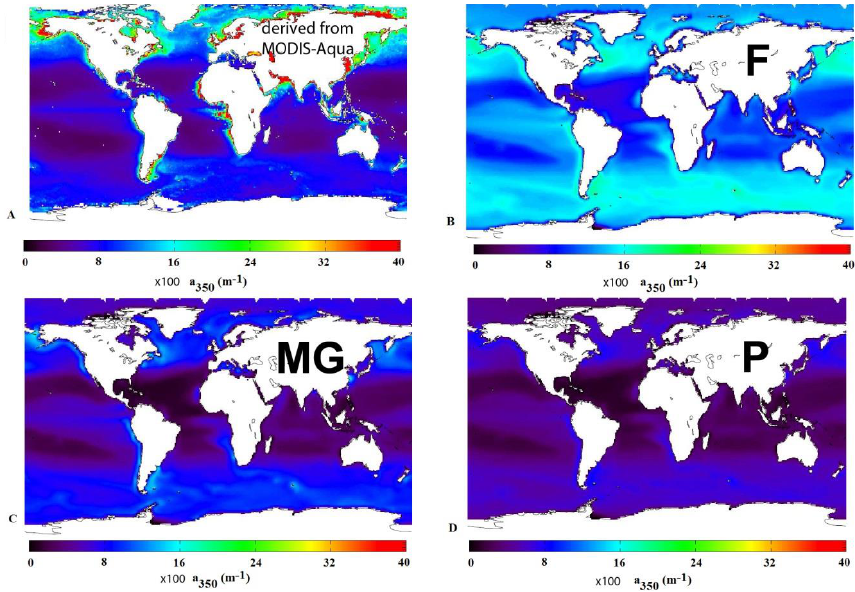
Figure 6. Comparison between annual mean surface absorption coefficient of CDOM at 350nm: (a) retrieved from MODIS Aqua satellite data, using SeaUV model (Fichot et al., 2008) and a 320 / K d320 ratio from Fichot and Miller (2010), and a 350 maps simulated with the NEMO-PISCES model using the relationship described in Morel and Gentili (2009) (MG, c ), Preiswerk and Najjar (2000) (P, d ) and proposed in this work (F, b ).